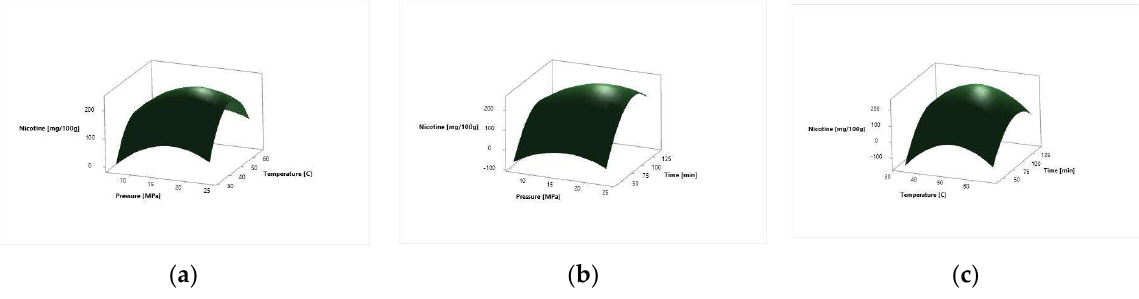
Figure 3. Surface response plots for the N. tabacum cv. Samsun leaves nicotine relative amount in a function of extraction: ( a ) pressure and temperature; ( b ) pressure and time; and ( c ) temperature and time.